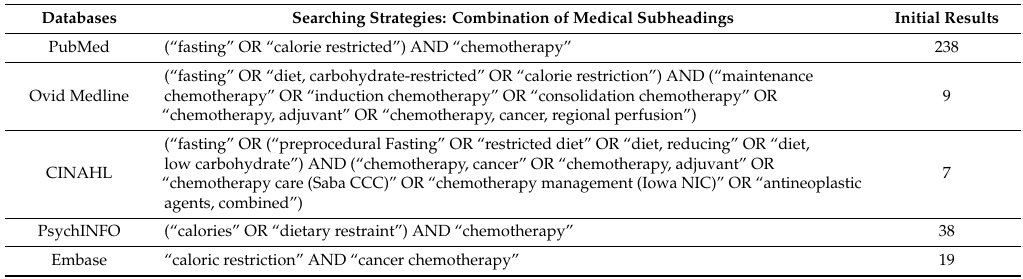
Table 1. Searched databases, searching strategies, and the number of initial results.